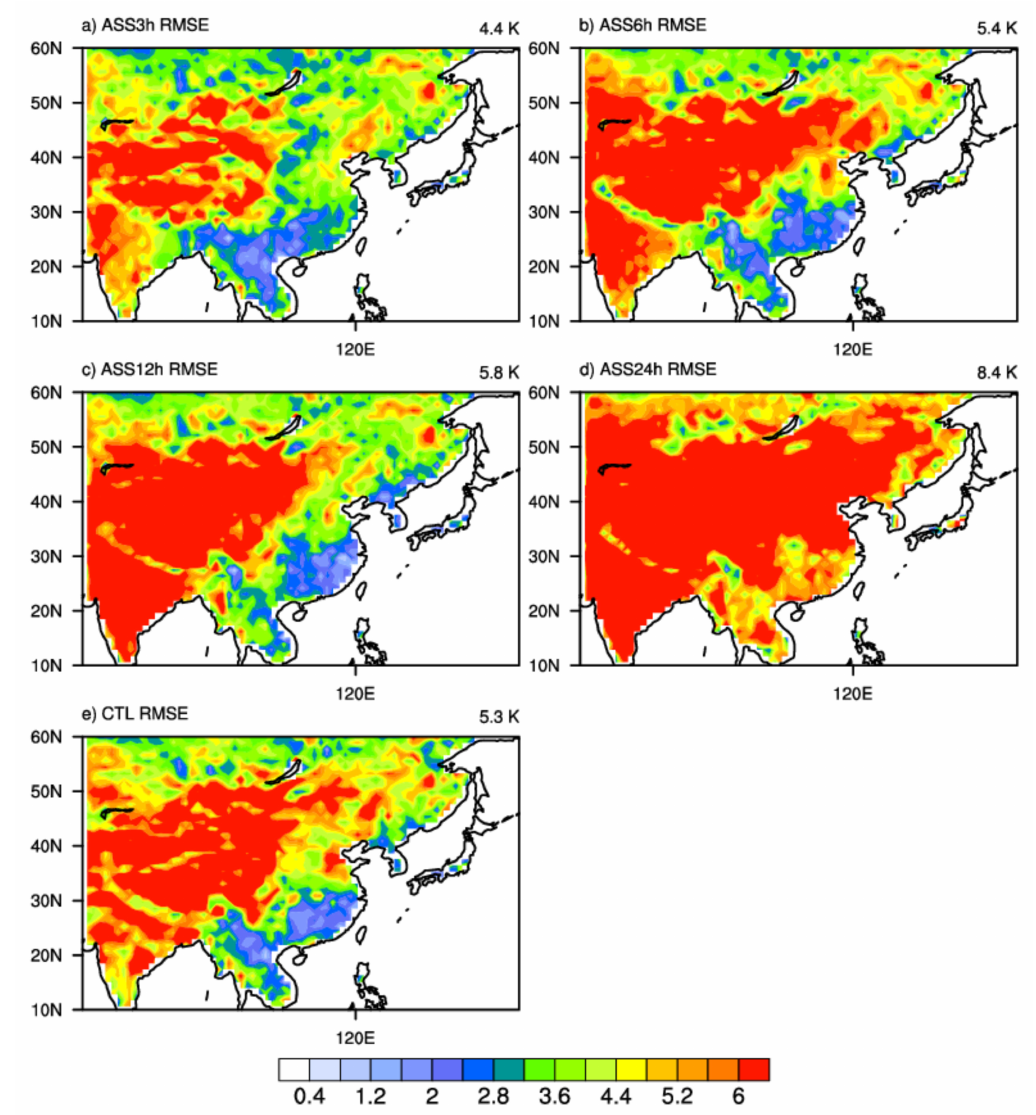
Figure 8. The spatial distributions of the RMSE (K) between the LST of ( a ) the ASS 3 h experiment, ( b ) the ASS 6 h experiment, ( c ) the ASS 12 h experiment, ( d ) the ASS 24 h experiment, and ( e ) the CTL experiment and the daytime MODIS